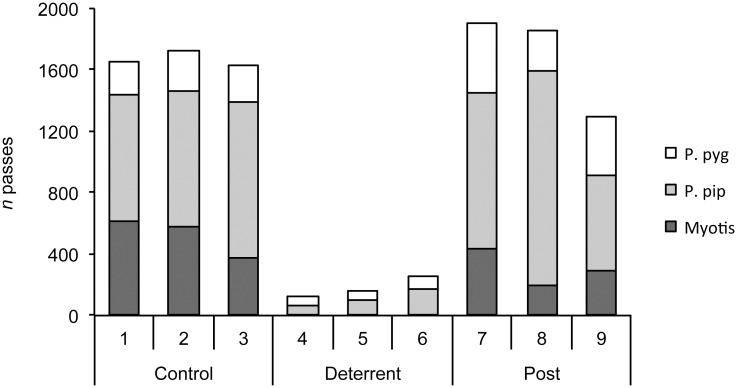
Response of bats to artificial lighting in churches.The figure shows the total number of bat passes (n = 4 sites) recorded each night in experimental lit zones inside churches during control (ambient light), deterrent (artificial light) and post-deterrent (ambient light) periods. P. pyg = soprano pipistrelle Pipistrellus pygmaeus; P. pip = common pipistrelle P. pipistrellus; Myotis = Myotis nattereri.